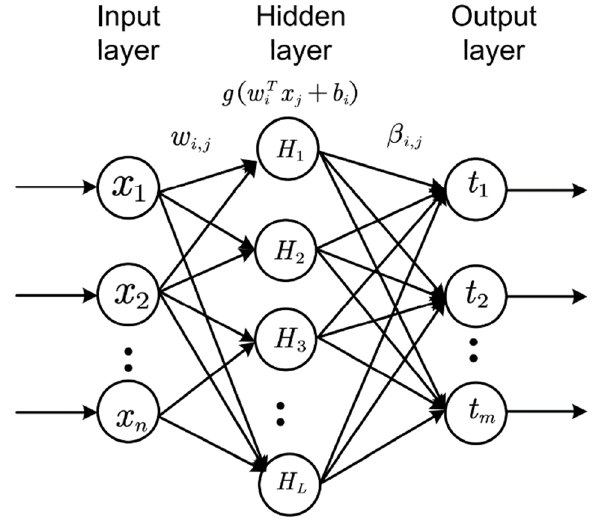
Figure 4. Architecture of single hidden layer extreme learning machine ELM.